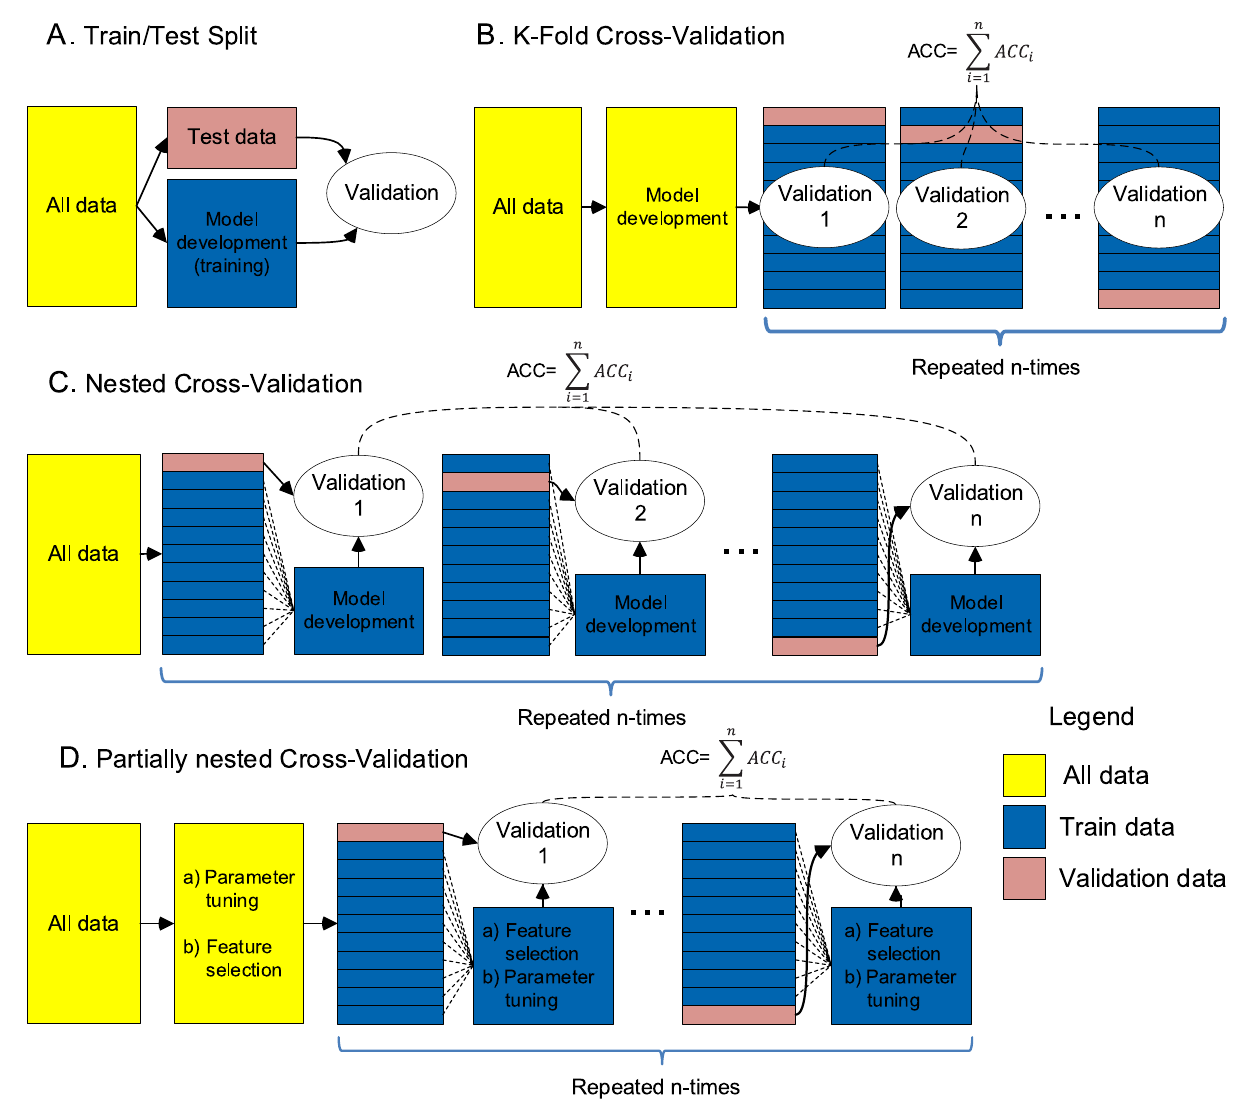
Fig 2. Validation methods. A : Train/Test Split. B : K-Fold CV. C : Nested CV. D : Partially nested CV. ACC—overall accuracy of the model, ACC accuracy in a single CV fold.